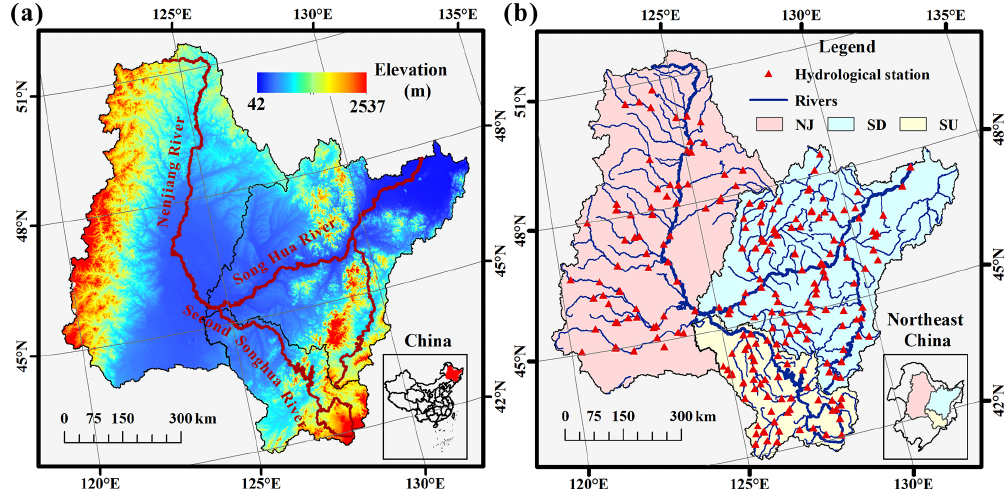
Figure 1. The geographic location of the Songhua River Basin showing (a) the elevation and (b) the location of 156 hydrological stations. The Songhua River Basin includes three subbasins: the Nenjiang River Basin (NJ), the downstream Songhua River Basin (SD), and the upstream Songhua River Basin (SU). Elevation data are from the Shuttle Radar Topography Mission (SRTM) with a spatial resolution of